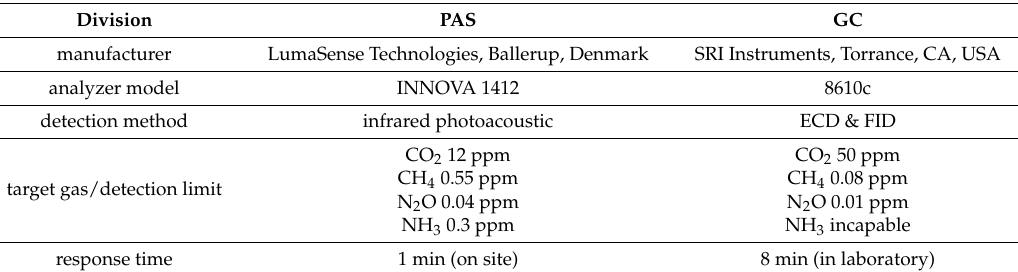
Table 1. Comparison of the gas analyzers used for detecting CO 2 , CH 4 , and N 2 O with the infrared photoacoustic system (PAS) and gas chromatography